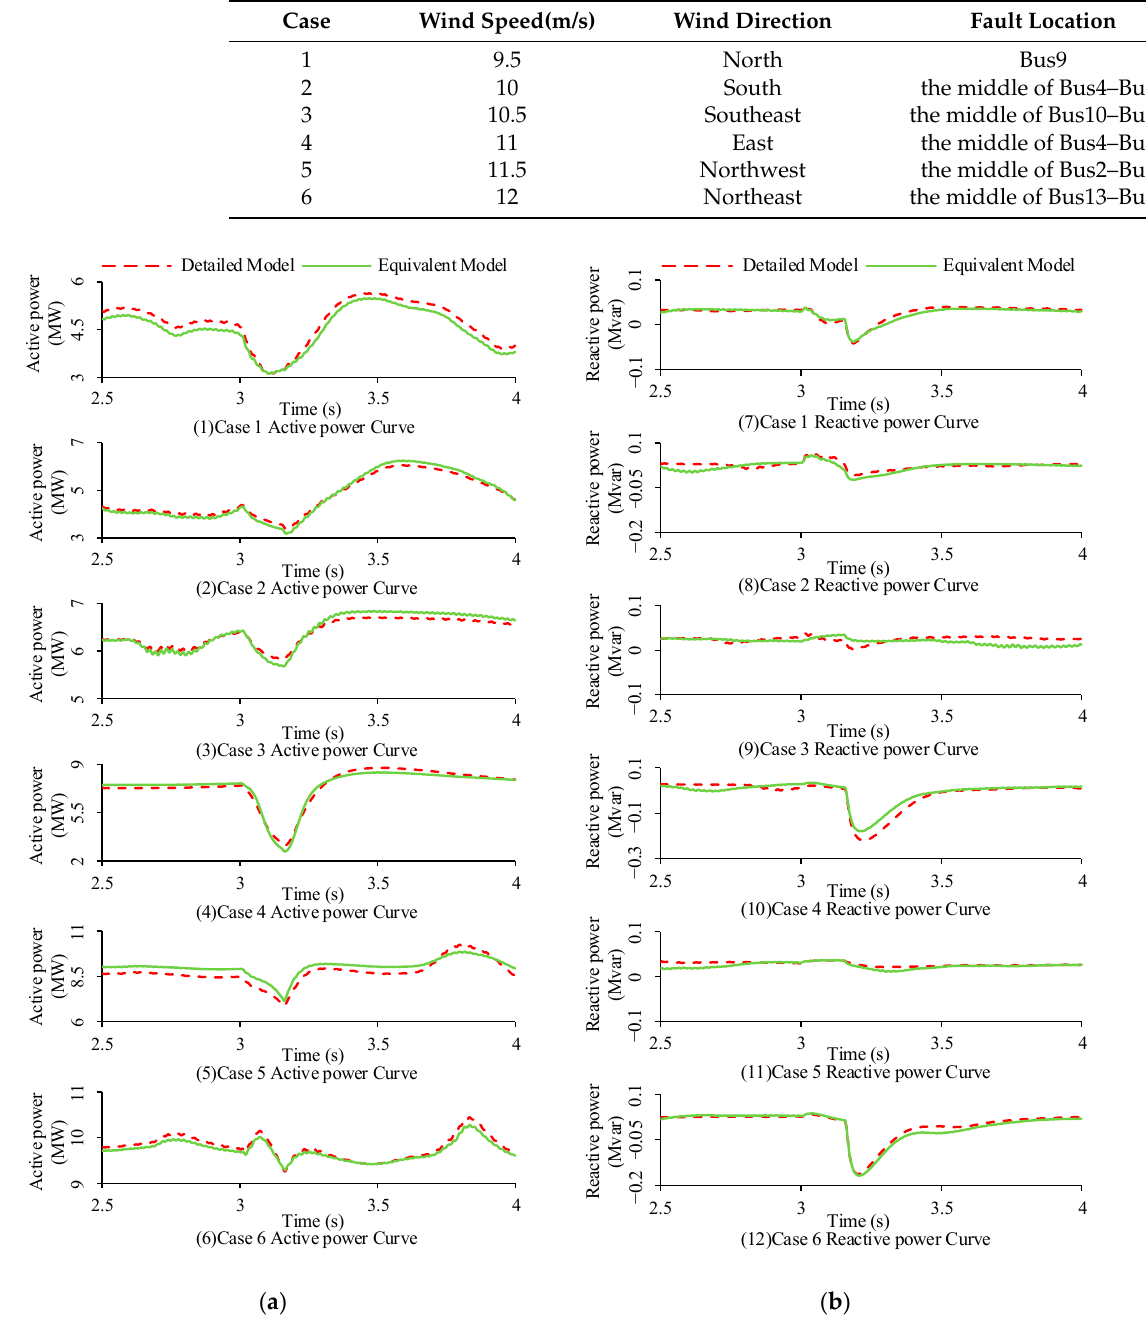
Table 4. Operating conditions of WF.